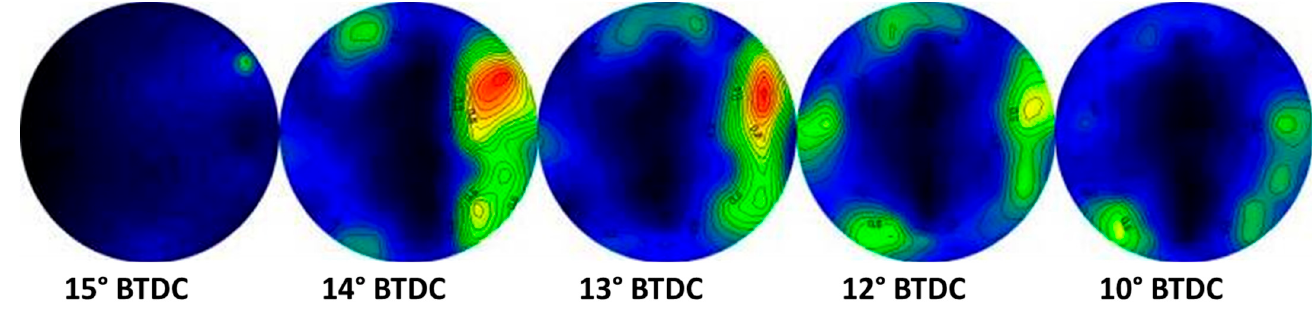
Figure 4. OH spatial distribution during auto-ignition and combustion phase at 1000 rpm at 700 bar. The experimental in-cylinder pro fi les with fi ve early injections strategy at varying rail pressure when the engine speed is equal to 1000 rpm are reported in Figure 5. The inlet pressure is set equal to atmospheric pressure for this engine operation, whereas the